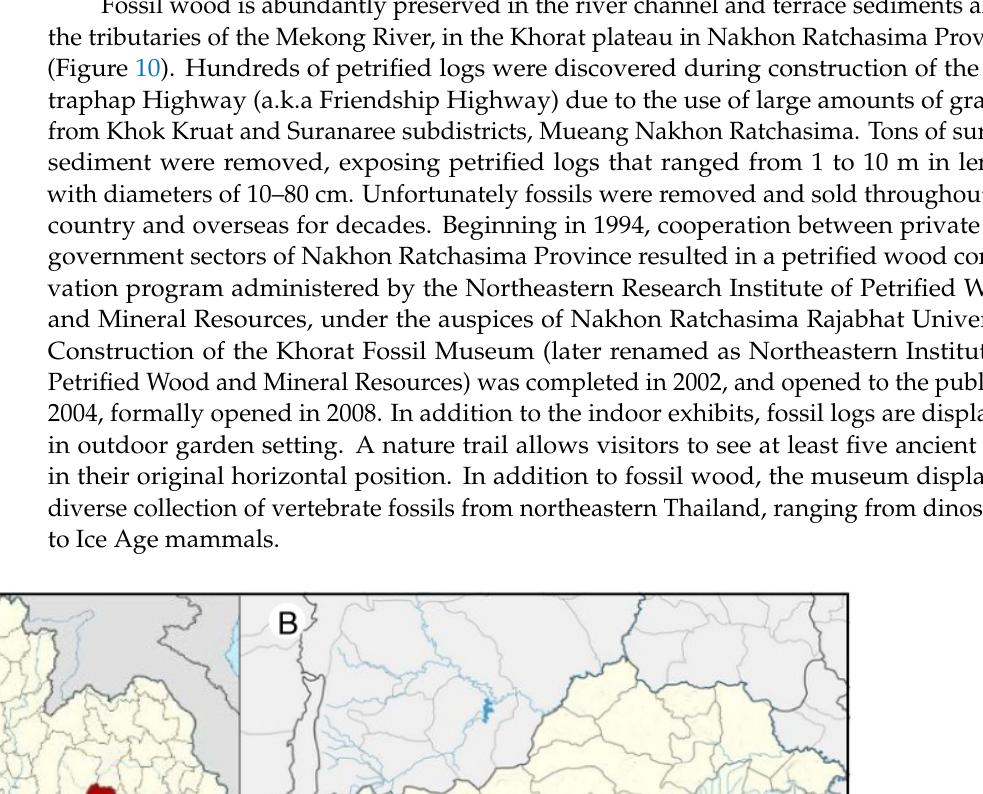
Figure 11. Khorat Plateau fossil wood specimens used for this study, showing specimen numbers. Samples are from Nakhon Ratchasima Province, except S-8, which is from Kohn Kaen Province. Table 2. Density and mineral composition of fossil wood specimens from locations in Nakhon Ratchasima Province. Specimen